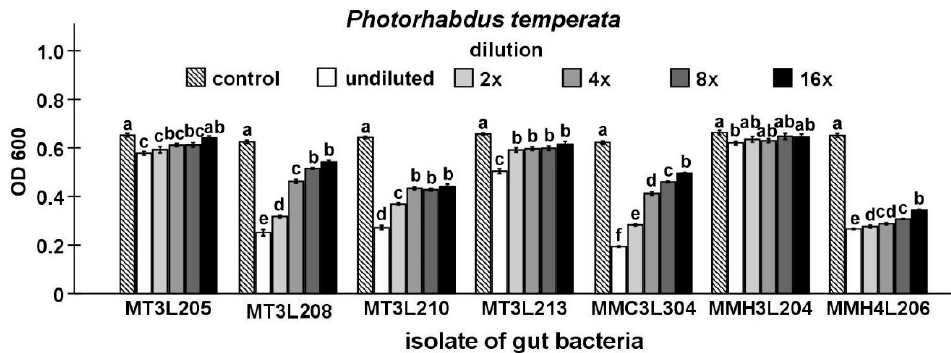
Figure 3. Antagonistic activities of different dilutions of culture supernatants from selected M. melolontha midgut isolates against P. temperata shown by Maximum Inhibitory Dilution (MID) tests. The same letters mean no significant differences between the activities of supernatants from the same midgut isolate.